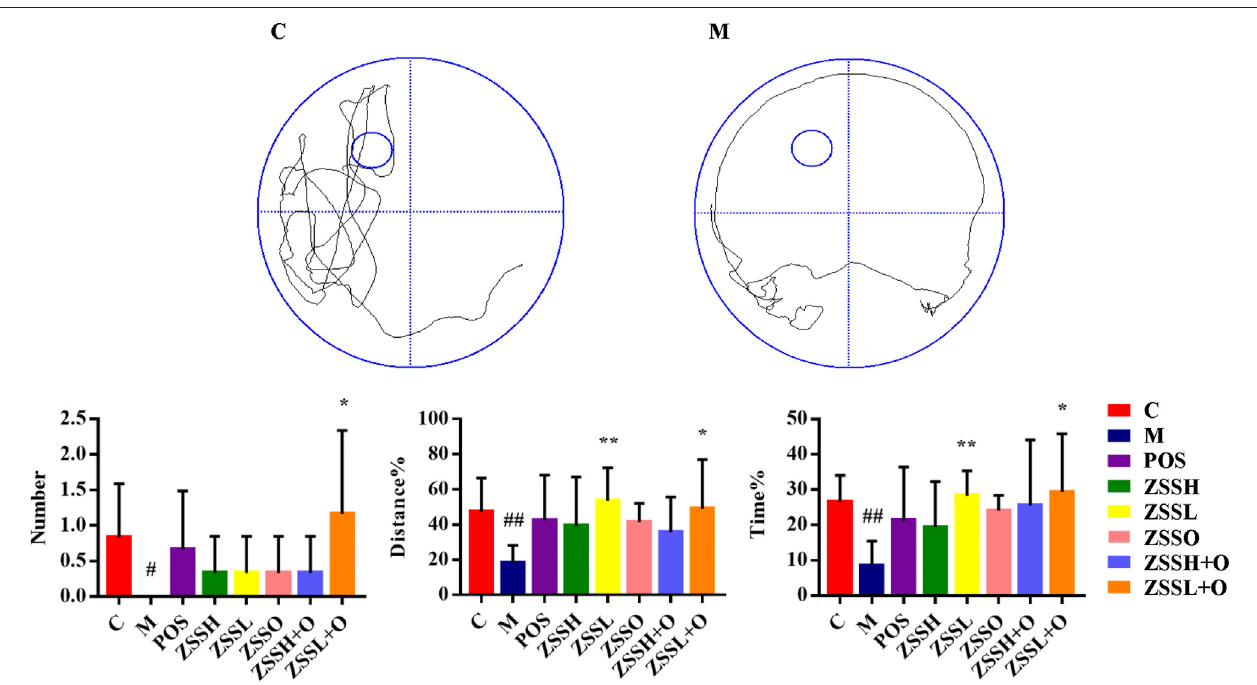
FIGURE 2 | MWM evaluation indexes. (C) control group; (M) model group; (POS) positive group; (ZSSH) high-dose ZSS ethanol extract group; (ZSSL) low-dose ZSS ethanol extract group; (ZSSO) ZSS oil extract group; (ZSSH + O) high-dose ZSS ethanol + oil extract group; (ZSSL + O) low-dose ZSS ethanol + oil extract group. Values are presented as the mean ± SD, n (cid:2) 6. # p < 0.05, ## p < 0.01: model vs control; * p < 0.05, ** p < 0.01: treatment vs